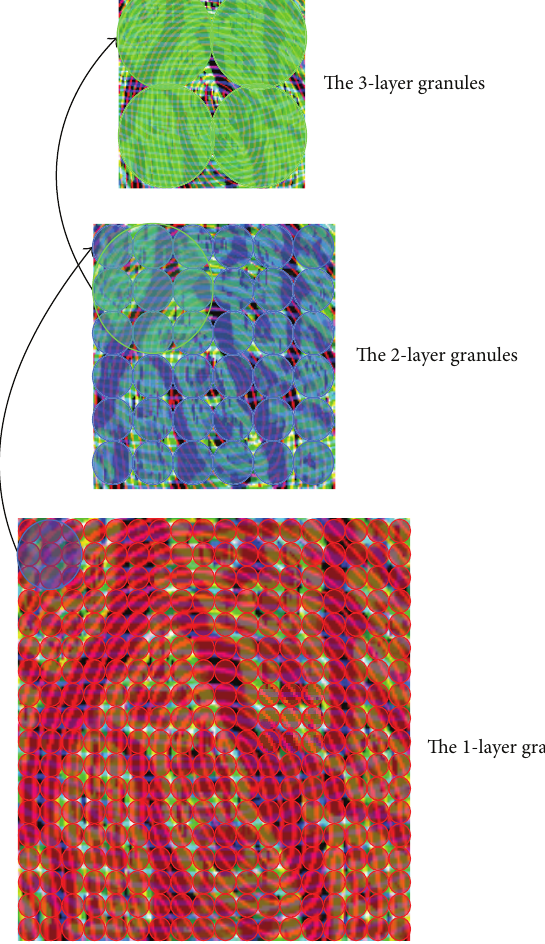
Figure 5: The 3-layer bottom-up granulation